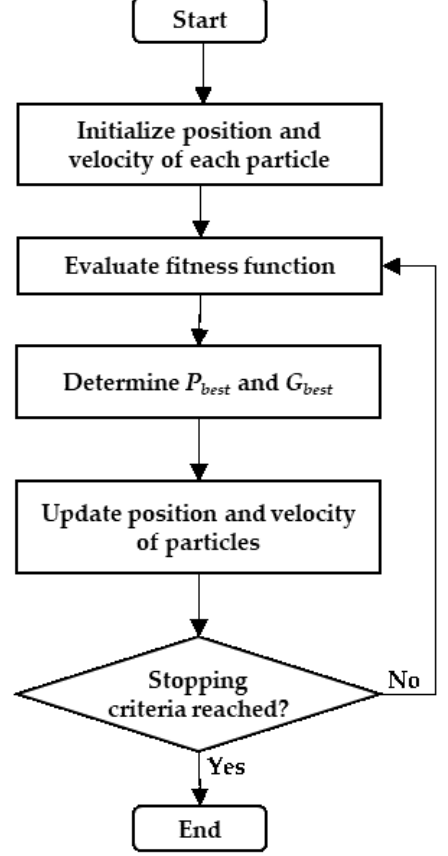
Figure 11. PSO algorithm